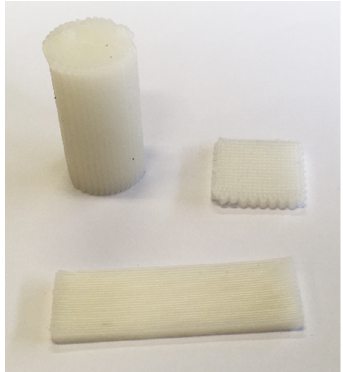
Figure 13. PCL/RT27_20% printed samples.